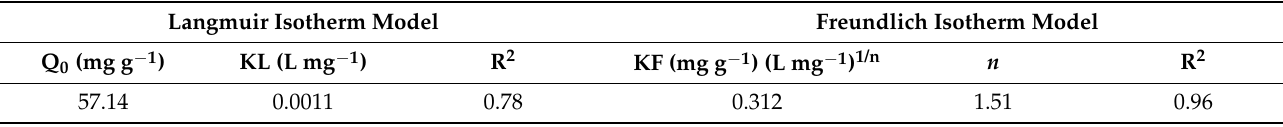
Table 5. Langmuir and Freundlich isotherm model parameters.